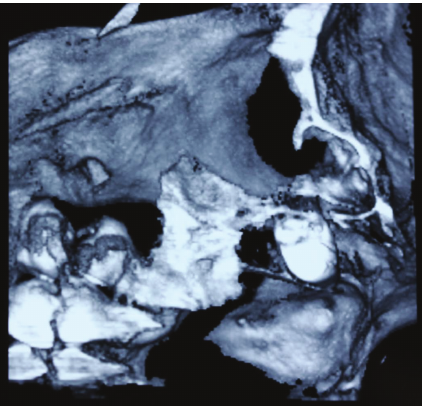
Figure 3: CT revealed that the root was stuck in the antrum of pterygopalatine